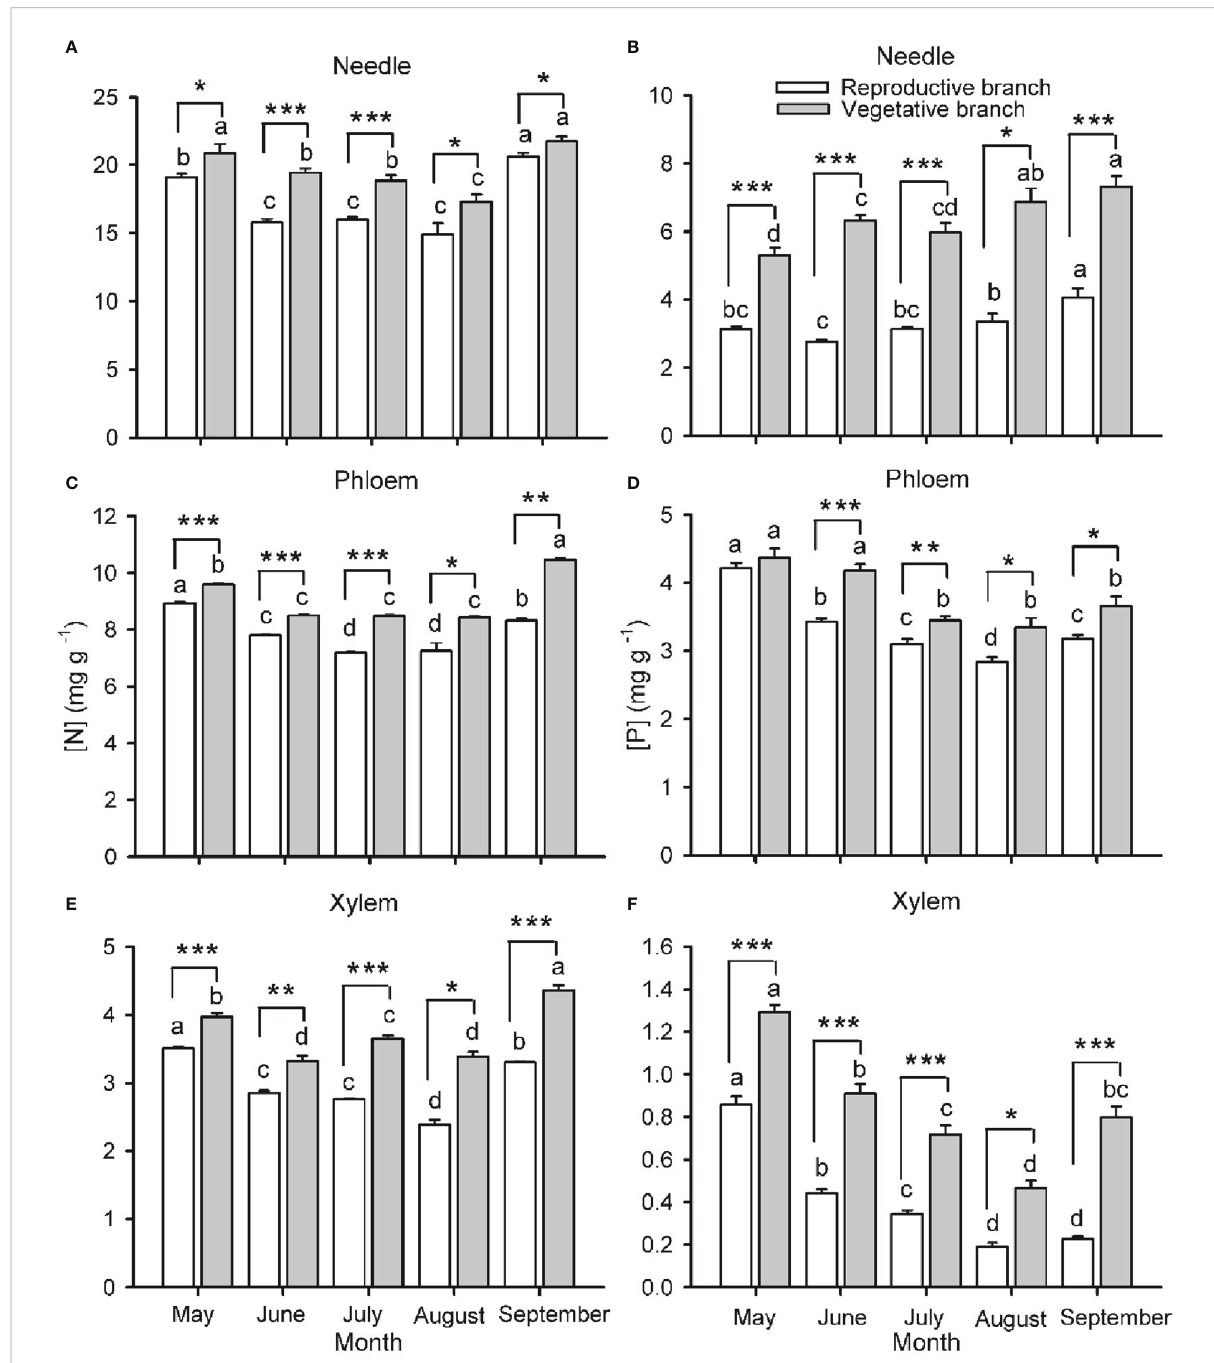
FIGURE 3 Nitrogen ( [N]; A, C, E) and phosphorus ( [P]; B, D, F) concentrations in needles (A, B) , phloem (C, D) and xylem (E, F) in two-year-old twigs of Pinus koraiensis at fi ve sampling times (May, June, July, August and September, corresponding to DOYs 128, 172, 204, 237 and 258, respectively). Bars and arrows represent the mean and corresponding standard error from fi ve trees, respectively. Asterisks indicate signi fi cant differences between branch types for a given harvest time; *, ** and *** indicate signi fi cance levels at P < 0.05, 0.01 and 0.001, respectively. Different lowercase letters indicate signi fi cant differences between harvest times for a given branch